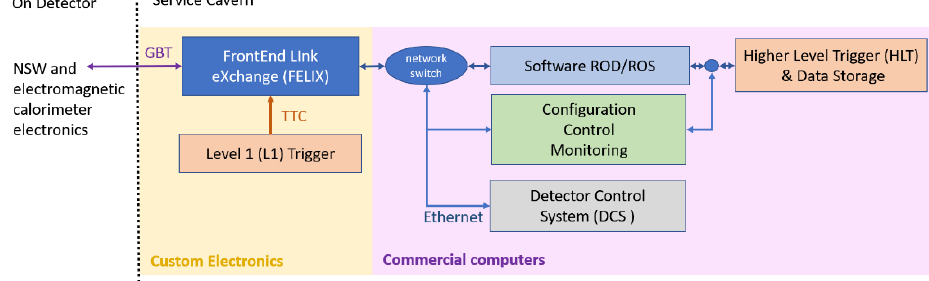
Figure 2. The upgraded ATLAS readout system. Data is routed by a custom designed FELIX board from the front-end detector electronics onto commercial computers. The commercial computers contain software to perform the data processing in the Software ROD/ROS, as well as detector control, monitoring, configuration, High-Level Trigger and Data Figure 1. The current ATLAS Readout System. Custom designed Readout Drivers (ROD) and